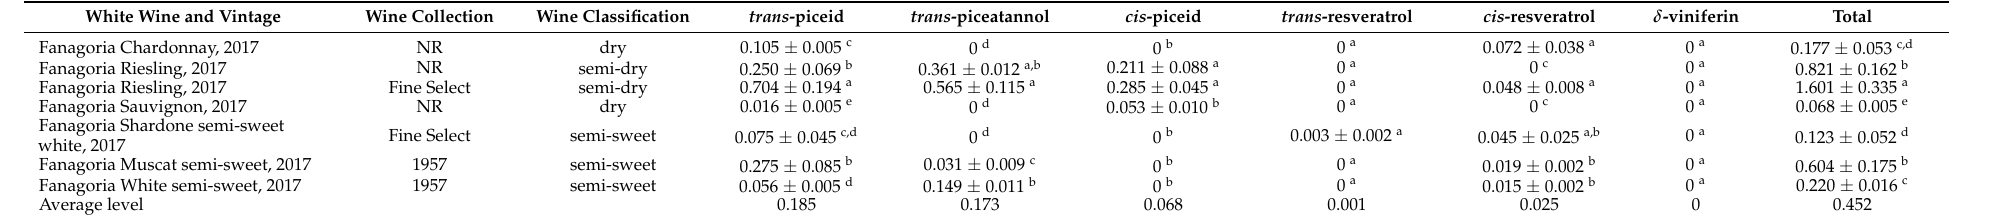
Table 2. The content of stilbenes in the white Russian Fanogoria wines (mg/L).